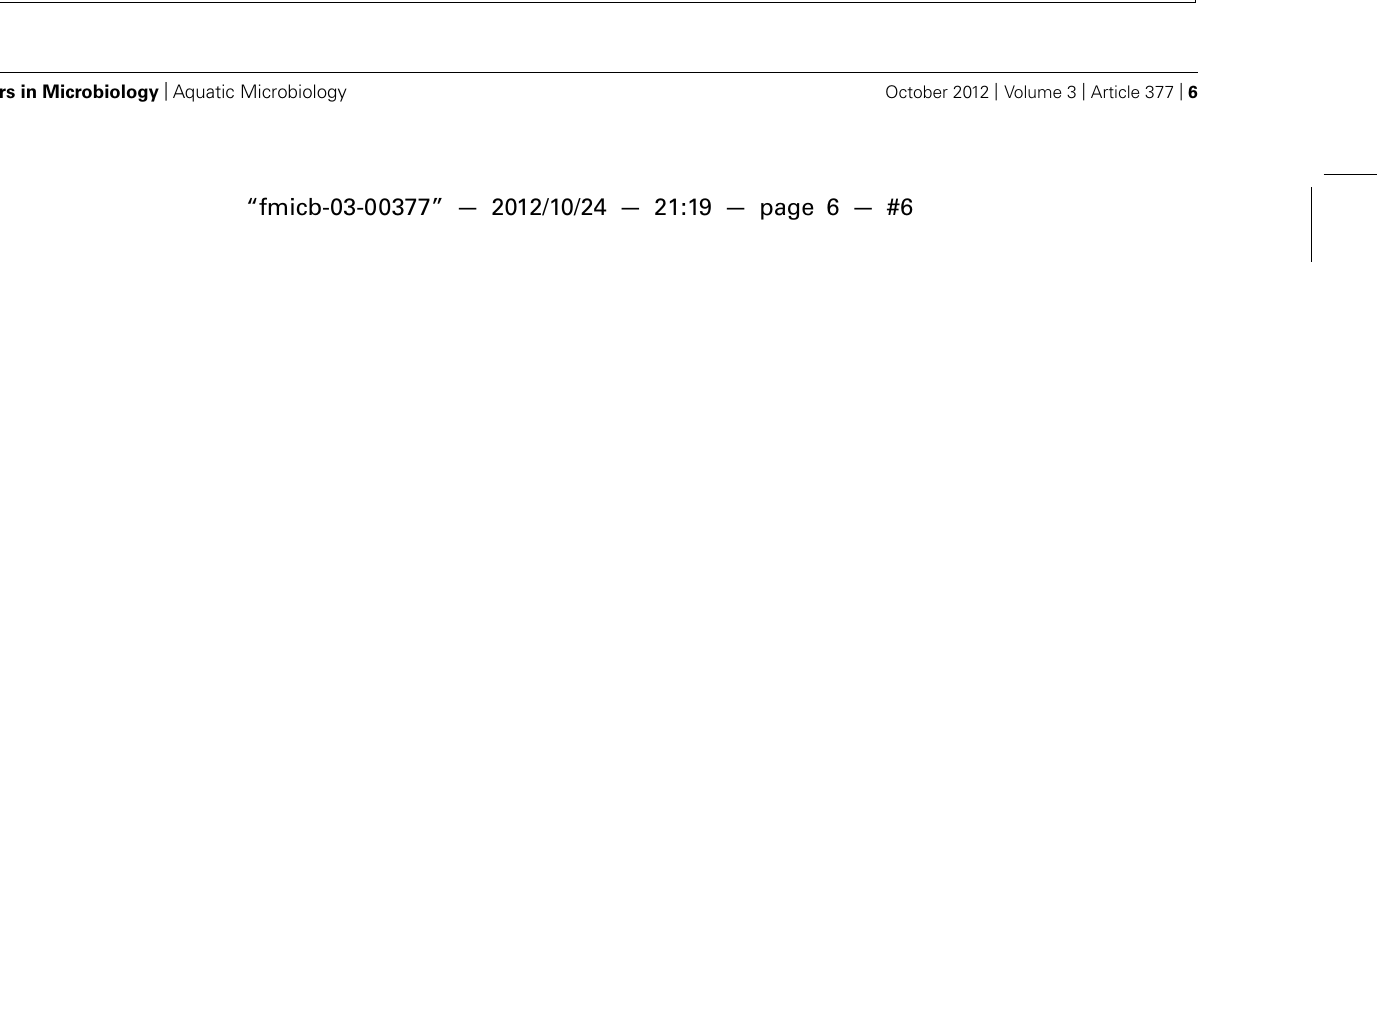
FIGURE 3 | 16S rRNA bacterial gene phylogeny of Guaymas Basin environmental clones relative to pure culture and other environmental clones. Environmental clones from this work appear as bold text, pure cultures are italicized, and environmental clones from other environments